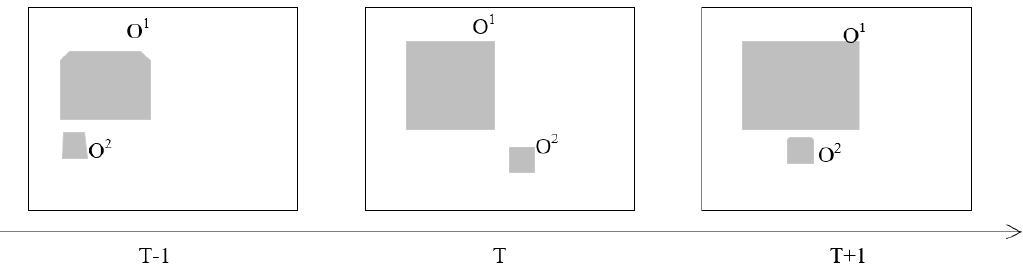
Figure 4. An example of determining a marine snapshot object from a marine spatiotemporal cluster.